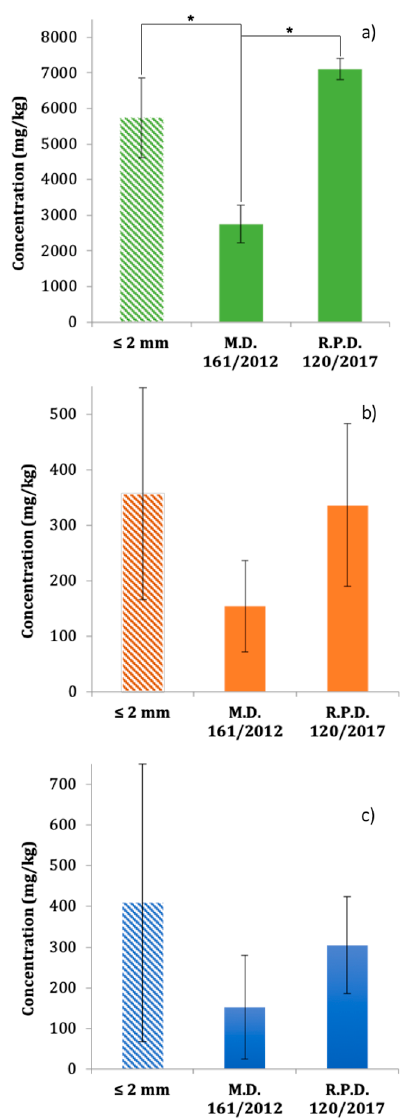
Figure 8. Histogram comparing the calculated average asbestos concentrations according to M.D. 161 / 2012 (middle column) and R.P.D. 120 / 2017 (right-hand column) for each sample: ( a ) serpentinite; ( b ) debris material, and ( c ) soil. The column to the left represents the concentration of asbestos in the grain size fraction ≤ 2 mm (0.160–2 mm) unrelated to the skeleton. The black bars represent the standard deviation. Asterisks shown in figures indicate significant differences between groups (* = p < 0.05).